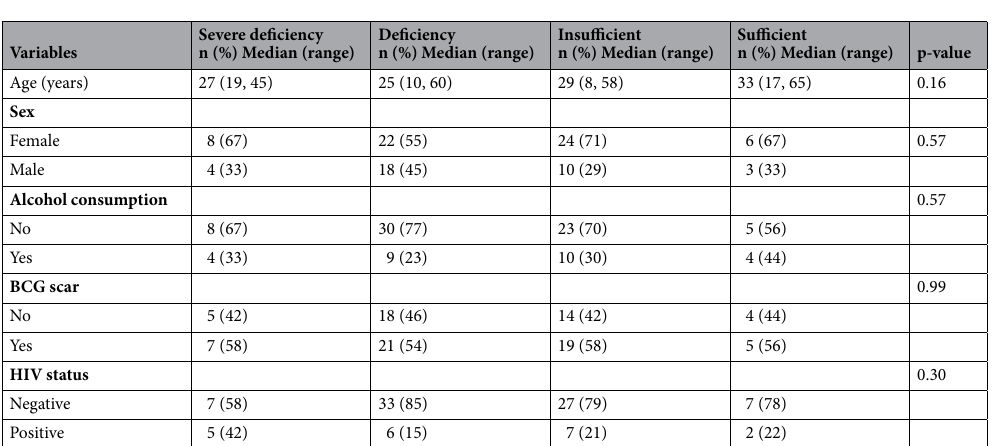
Table 4. Participant characteristics according to vitamin D levels. Severe deficiency < 10 ng/ml, deficient ≤ 20 ng/ml, insufficient 21–29 ng/ml, sufficient ≥ 30 ng/ml.